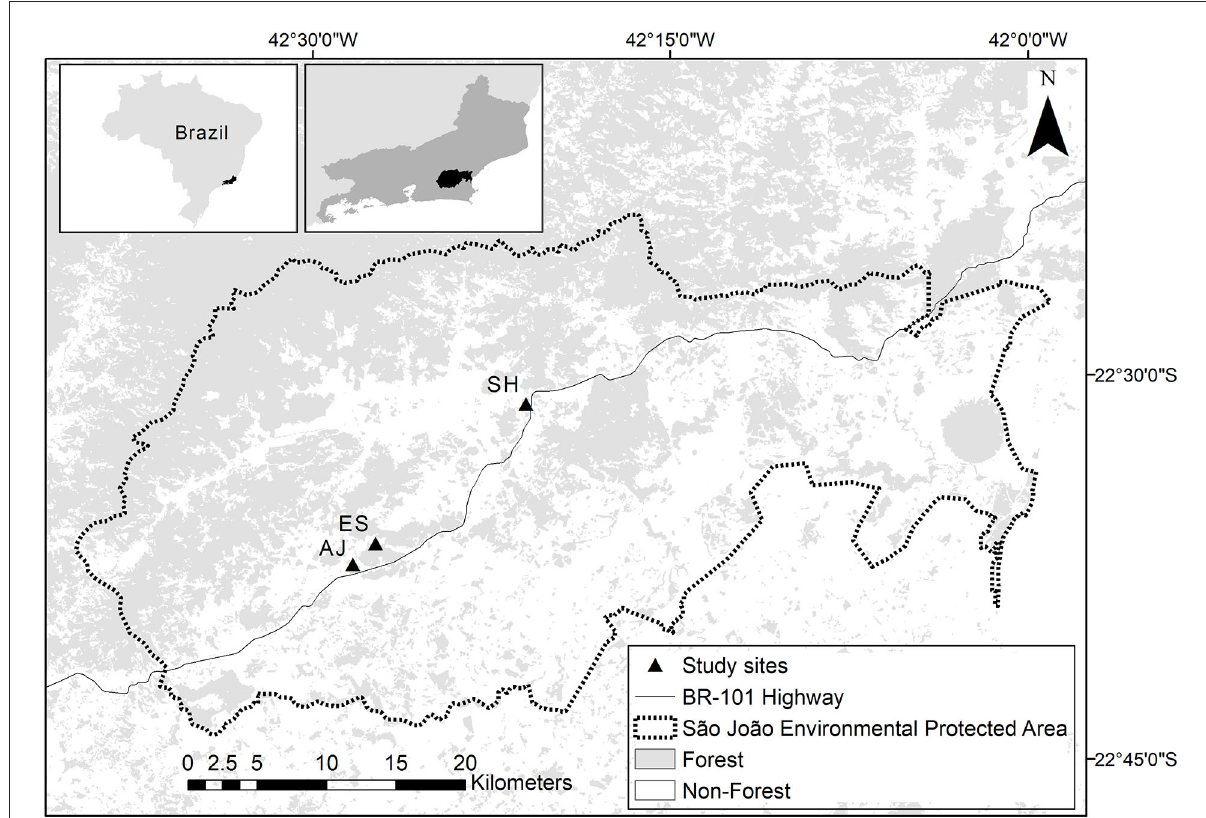
FIGURE1 Limits of the São João Environmental Protected Area, located in the central portion of the state of Rio de Janeiro (southeastern region of Brazil), with forest and non-forest areas and the respective locations of the three study sites, i.e., SH, AJ, and ES (the western portion of the protected area). The limits of biological reserves are represented by dashed